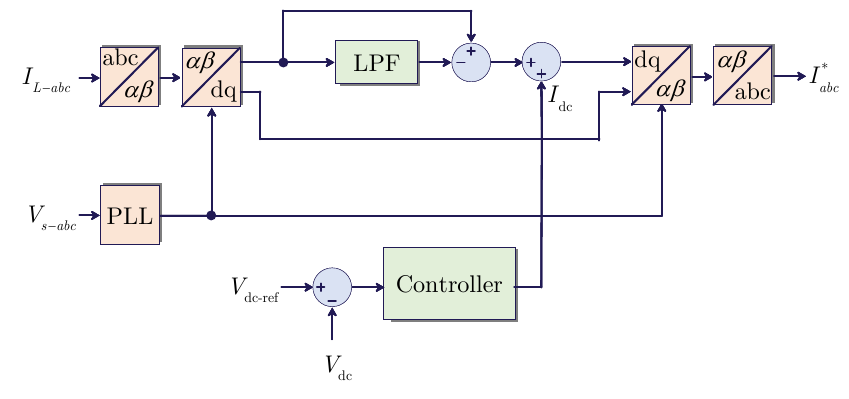
Figure 4. Control diagram of the shunt converter.